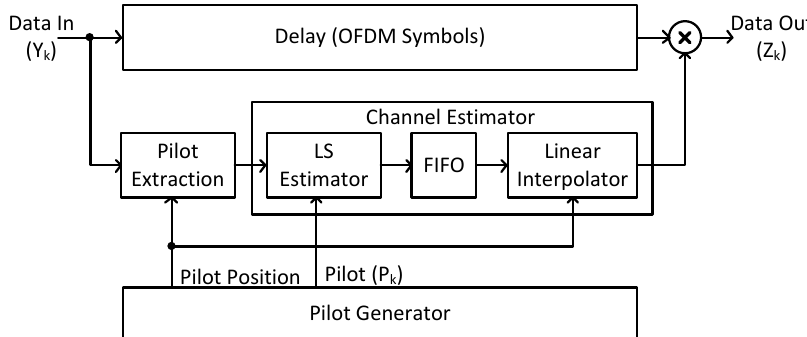
Figure 12. Block diagram of the channel estimator and equalizer.